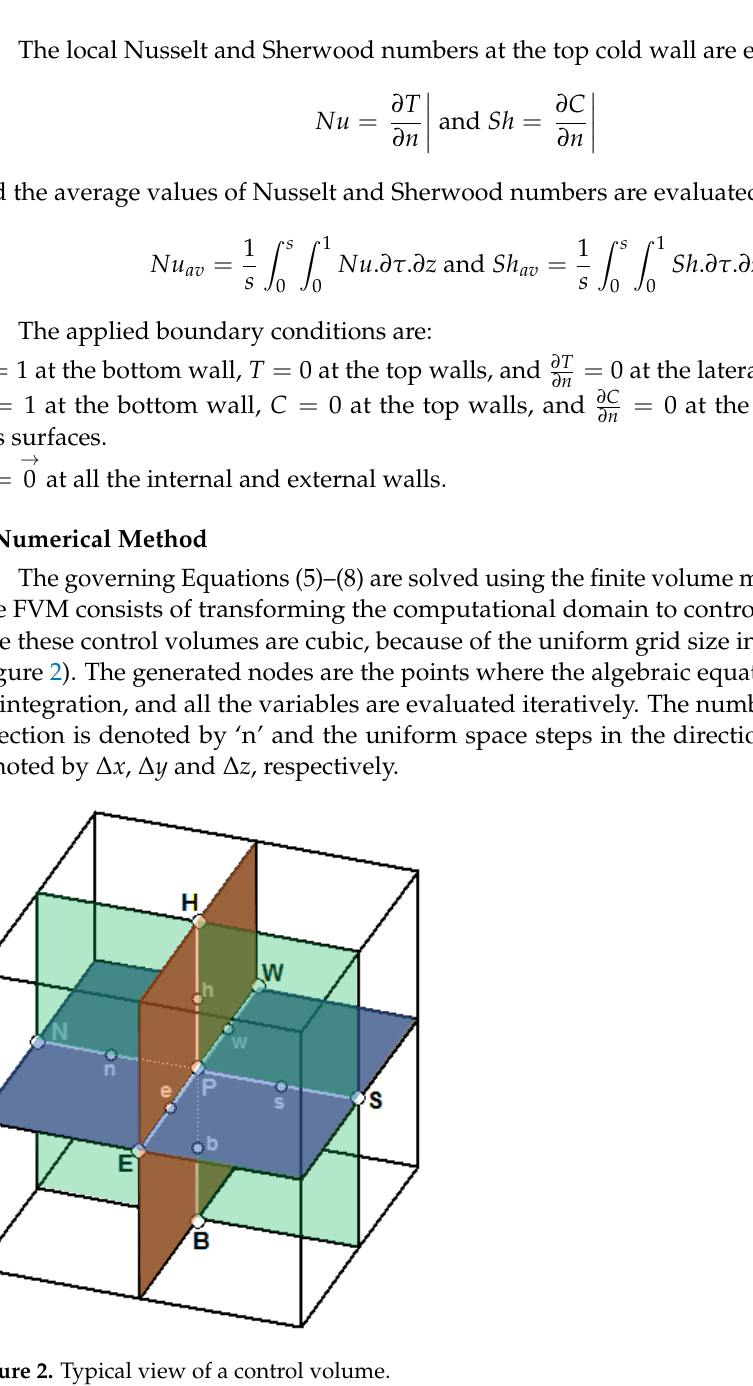
Figure 2. Typical view of a control volume.